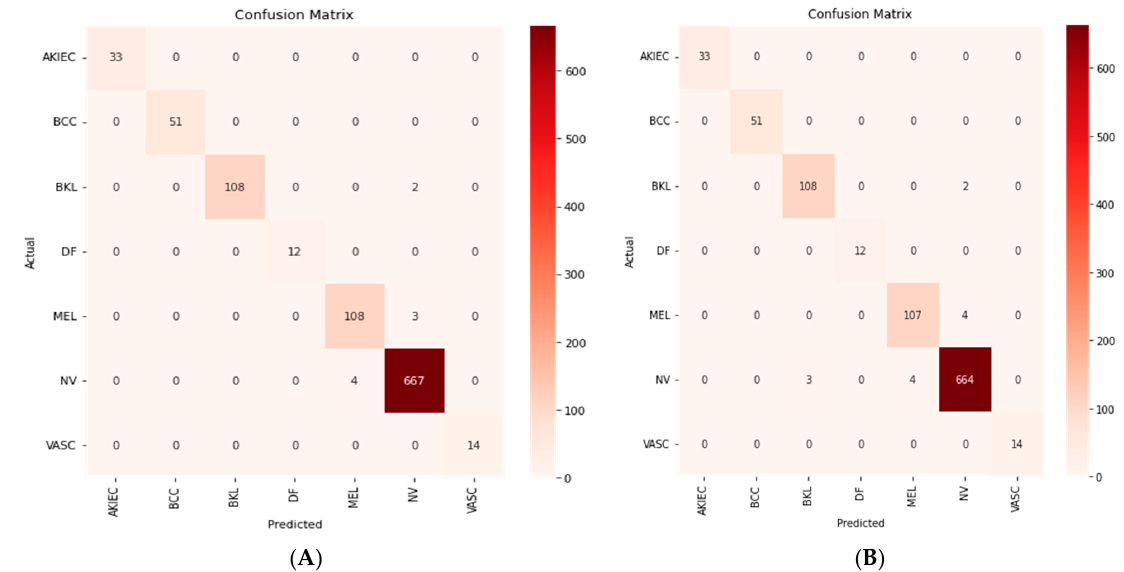
Figure 8. Confusion matrix of the proposed ensemble model ( A ) and the baseline EfficientNetV2S model ( B ).